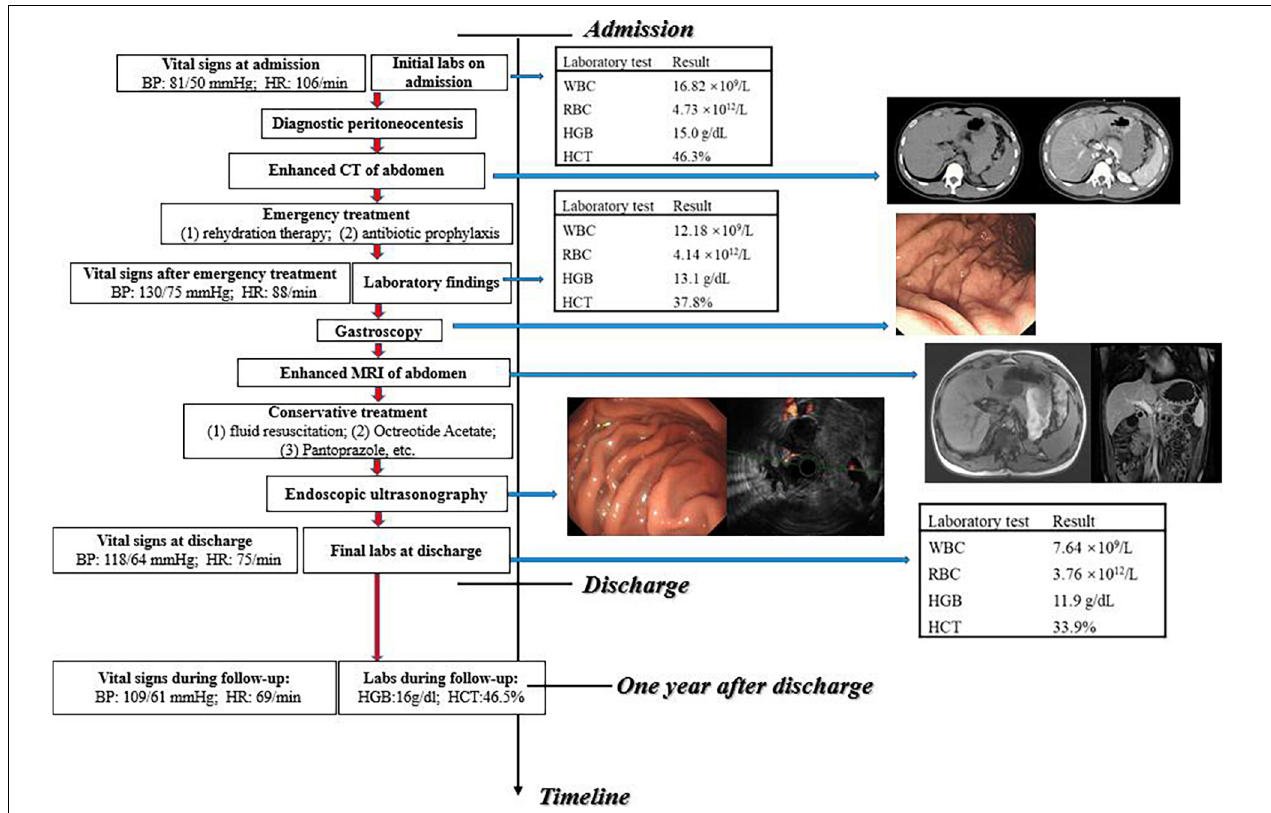
FIGURE 3 | Timeline from emergency to